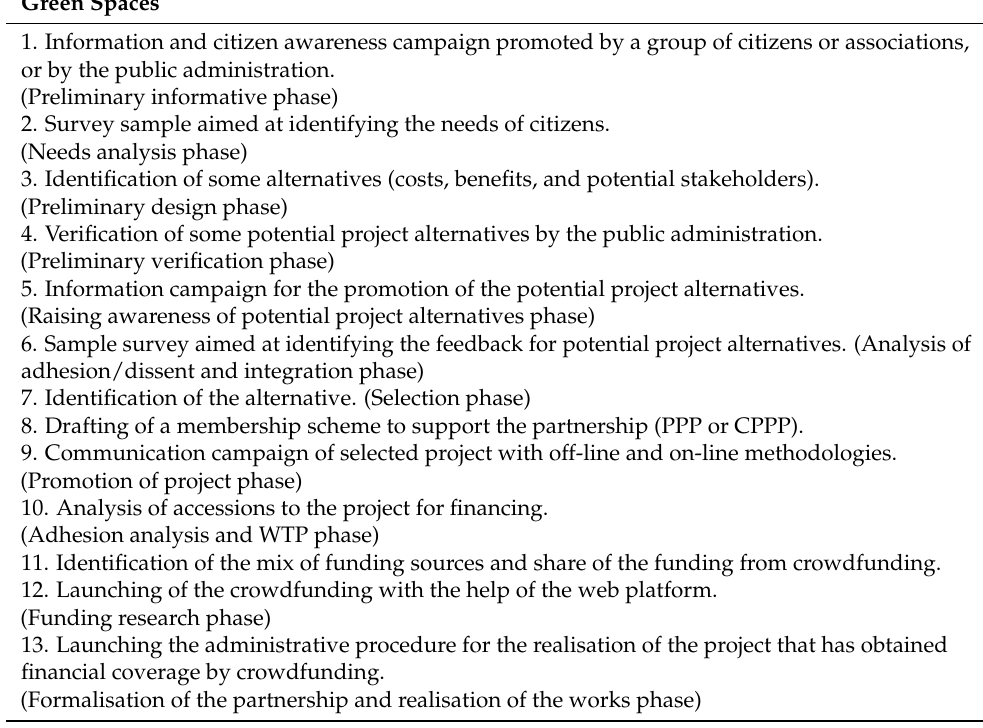
Table 1. The new approach to the rehabilitation of residual green urban areas intended for urban green